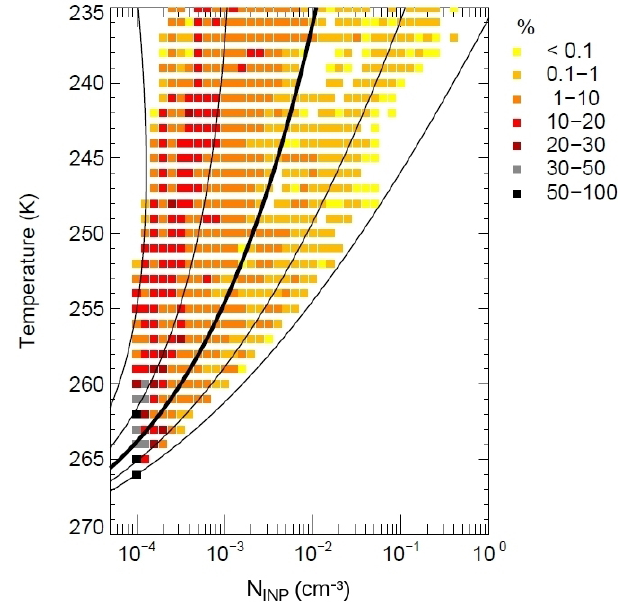
Figure 9. Frequencies of ice nucleating particle number con- centrations ( N INP ) vs. temperature for all measurement cam- paigns, colour coded by their frequency of occurrence. N INP is estimated from NIXE–CAPS measurements of aerosol con- centrations ( D p 0.6–3µm) following DeMott et al. (2010). The black lines indicate INP concentrations for constant aerosol concentrations of 0.01standardcm − 3 (leftmost line), 0.1standardcm − 3 , 1standardcm − 3 (thick line), 10standardcm − 3 and 100standardcm − 3 (rightmost